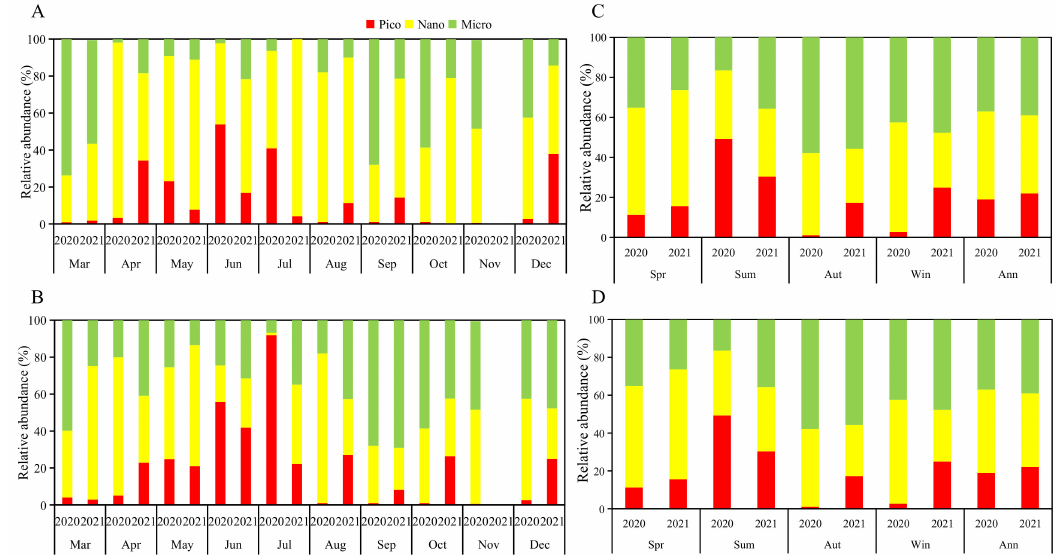
Figure 4. The biomass proportion of phytoplankton of different sizes in 2020 and 2021: ( A ) monthly in the stomachs; ( B ) monthly in the water; ( C ) seasonal in the stomachs; ( D ) seasonal in the